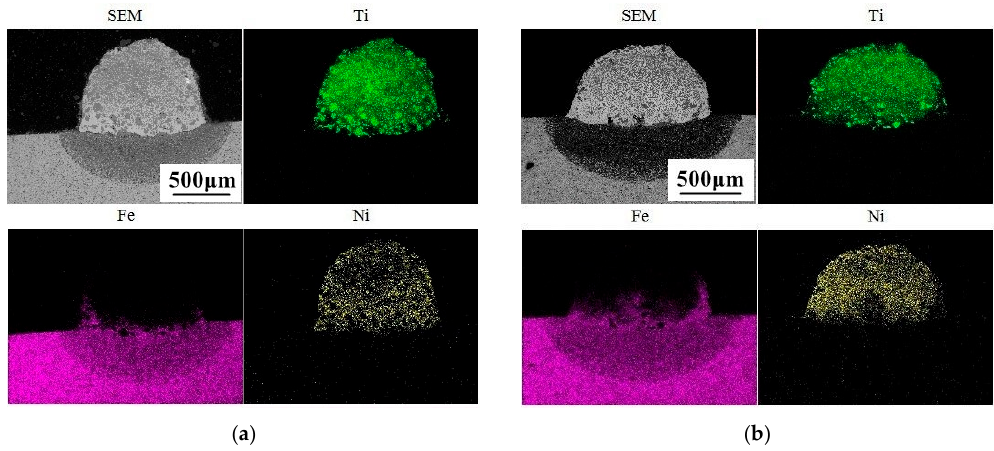
Figure 6. Element distribution of cladding layers at different laser powers. ( a ) 13# sample: 1.2 kW, 7 mm/s, 1000 L/h, 60% TiC; ( b ) 3# sample: 1.4 kW, 7 mm/s, 1000 L/h, 60% TiC.